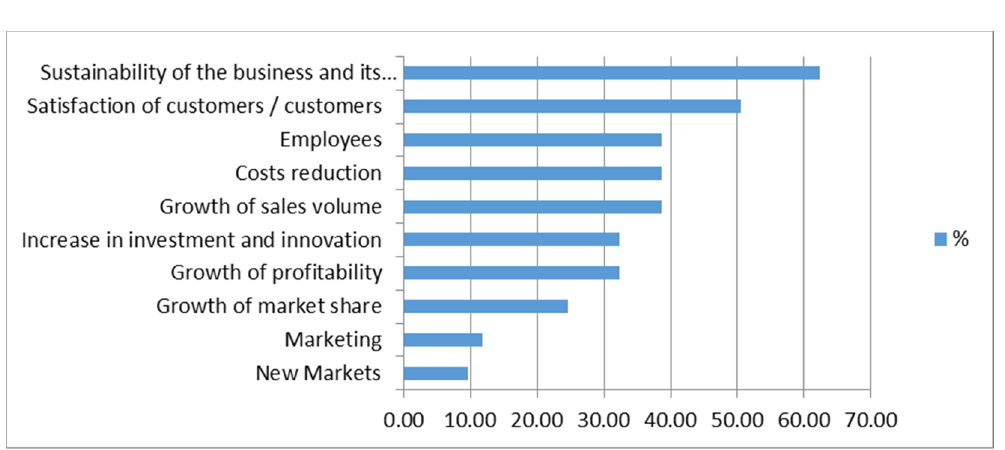
Figure 1. Areas of interest of companies within CSR (Corporate Social Responsibility) (Source: own research).